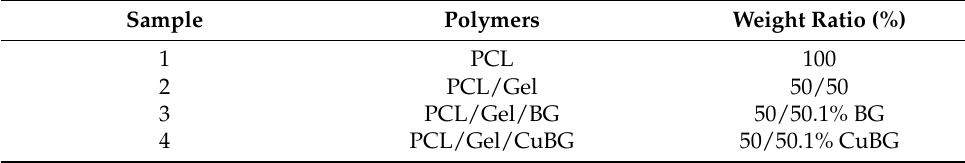
Table 2. Samples